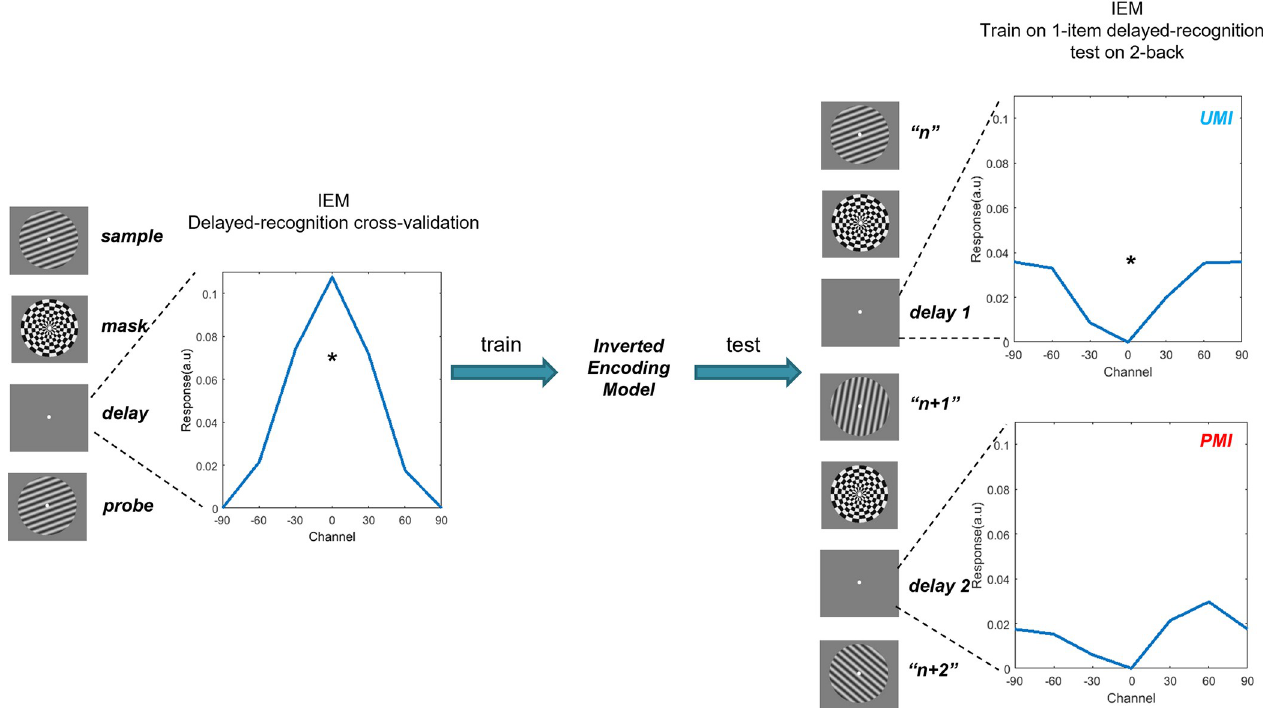
Fig 2. IEM reconstruction of EEG recorded while subjects performed the 2-back task ( N = 42, combining data from the pilot study and the preregistered experiment from Wan et al. [13]). In IEM, voltage from each EEG electrode is construed as a weighted sum of responses from six orientation channels (modelled by a half-wave-rectified sinusoid raised to the 6 th power), each tuned to a specific stimulus orientation, comprising the basis set. Left panel: IEM reconstruction of the stimulus during the delay in a separate one-item delayed-recognition task. This model was used to reconstruct the stimulus in the 2-back task. Right panel: Concatenation of the item n and item n + 1 stimulus events to form a trial, across which n transitions from probe to UMI to PMI in the 2-back. On the right are IEM reconstructions corresponding to the two 2 s windows centered in two 2.8 s post-mask ISIs before and after item n + 1 , respectively. “ � ” indicates p < .01 (two-tailed t test), FDR-corrected for multiple comparisons. As the figure shows, IEM reconstruction of stimulus n is “flipped” relative to the training data (IEM reconstruction from delayed recognition) when it is a UMI, demonstrating priority-based remapping. (Reconstruction of the PMI was unsuccessful.) For delayed-recognition IEM reconstruction (940–1040 ms from stimulus onset), t (41) = 4.12, p < 0.001. For UMI reconstruction of 2-back (-2400 –-400 ms relative to n + 1 onset), t (41) = -3.02, p = 0.009; for PMI reconstruction of 2-back (1150–3150 ms from n + 1 onset), t (41) = -1.60, p =